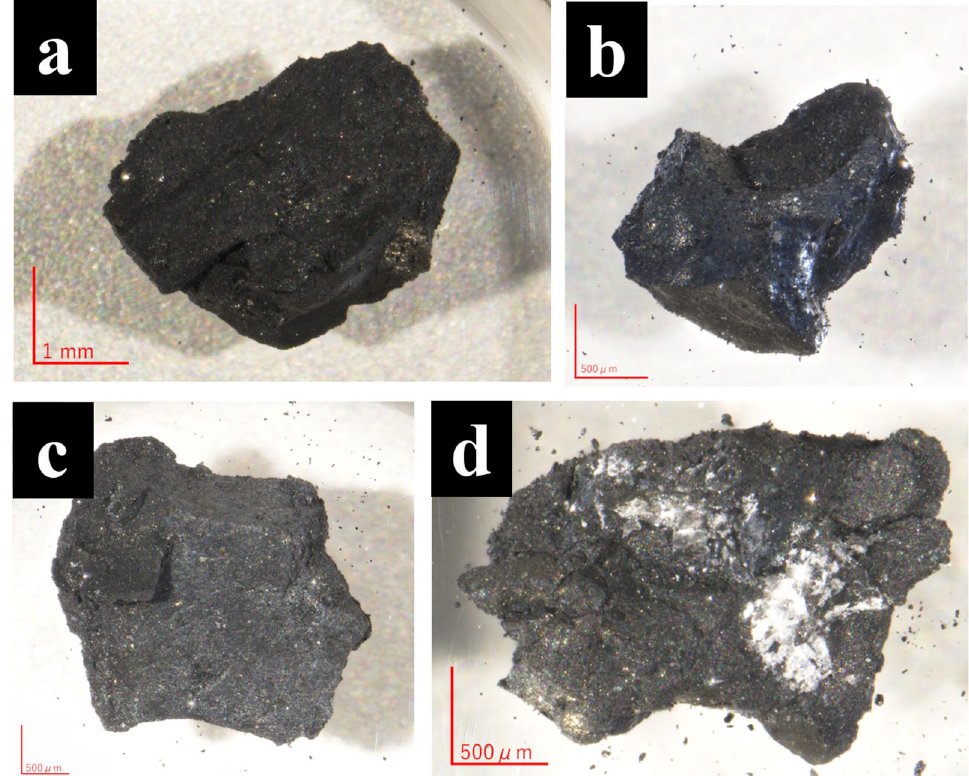
Fig. 1 Microscopic images of four representative grains. a A0042, dark group. This feature is dominant in Ryugu returned samples. b C0094, glossy group. Especially, the bottom part of this image shows shiny and glossy reflection. c A0017, bright group. Most of the flat surface of this grain shows bright color excluding upper left region corresponding with the dark lithology. d C0041, white group. One‑third of this grain exhibits white